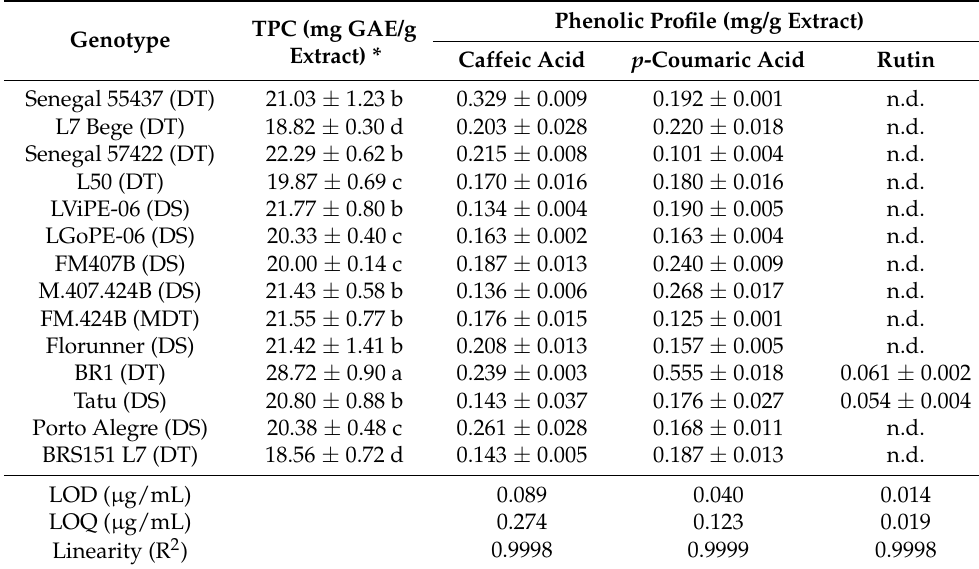
Table 2. Total phenolic content (TPC) and quantification using HPLC-PDA of phenolic compounds in optimized kernel extracts of peanut genotypes with varying levels of drought